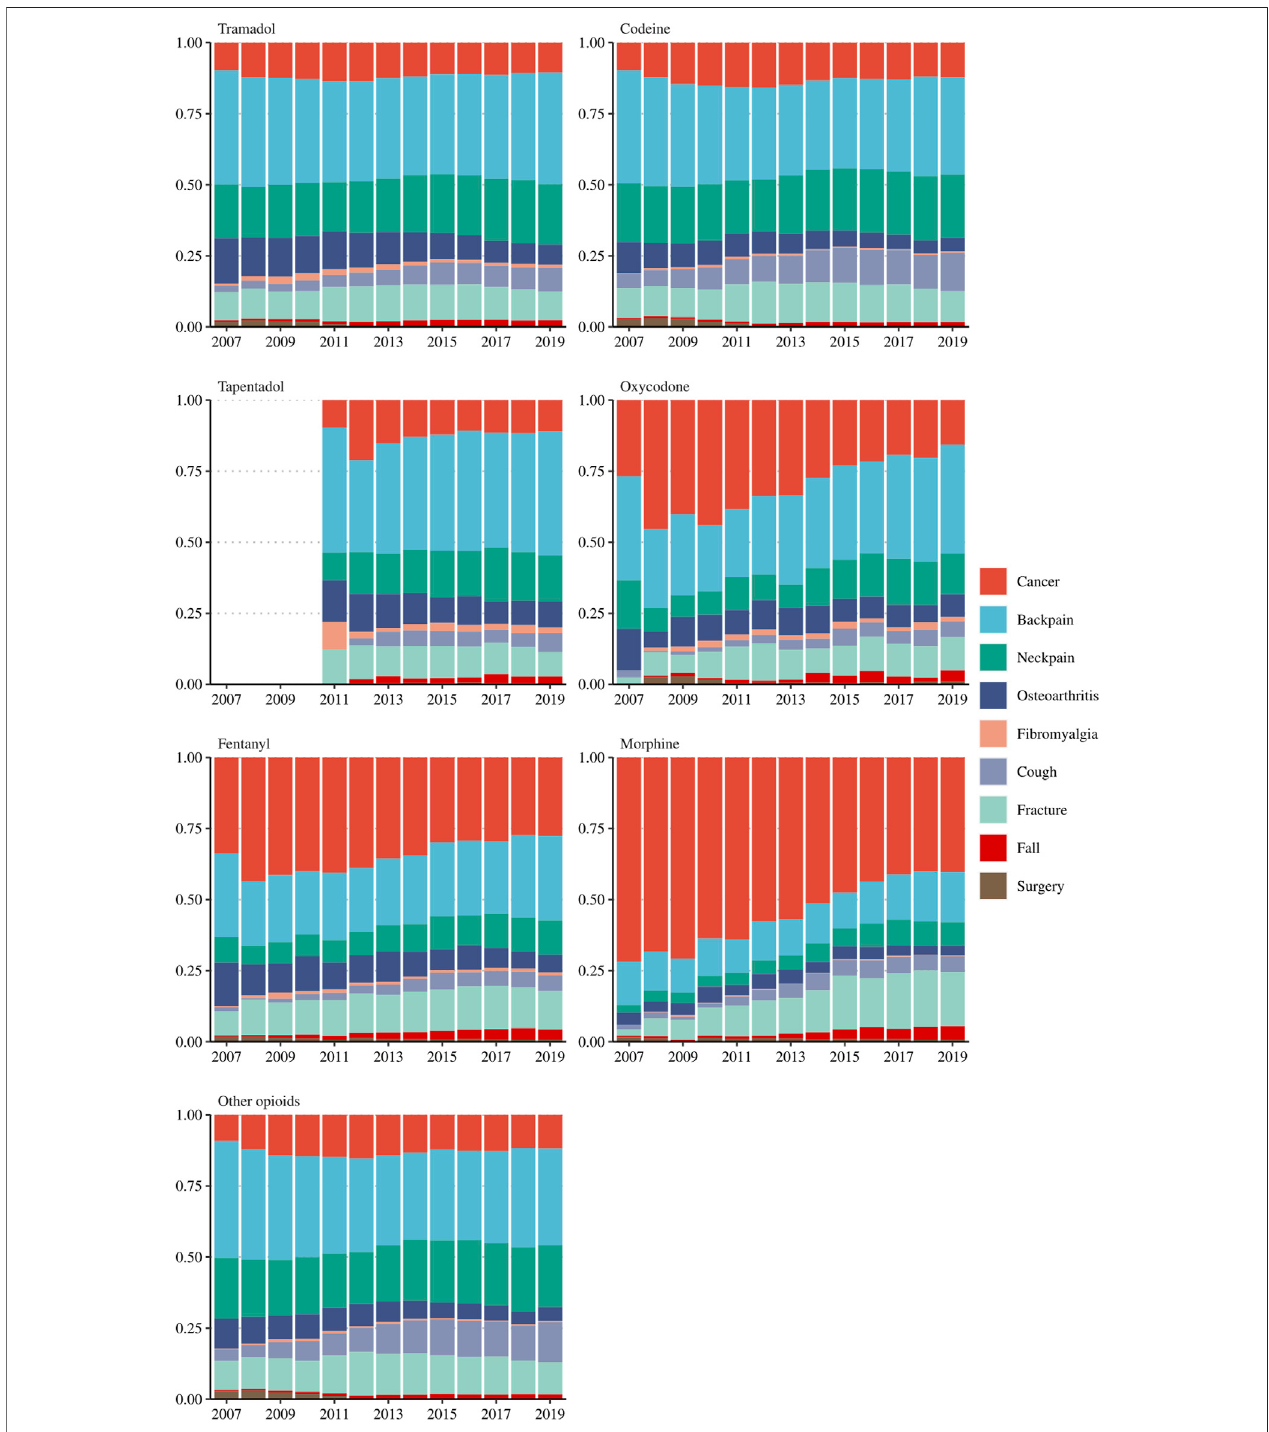
FIGURE 3 | The proportion of nine pain-related diagnoses among incident opioid users, strati fi ed by opioid subtypes. Other opioids included dihydrocodeine [N02AA08], hydromorphone [N02AA03], dextropropoxyphene [N02AC04], buprenorphine [N02AE01], pethidine [N02AB02], and pentazocine [N02AD01].